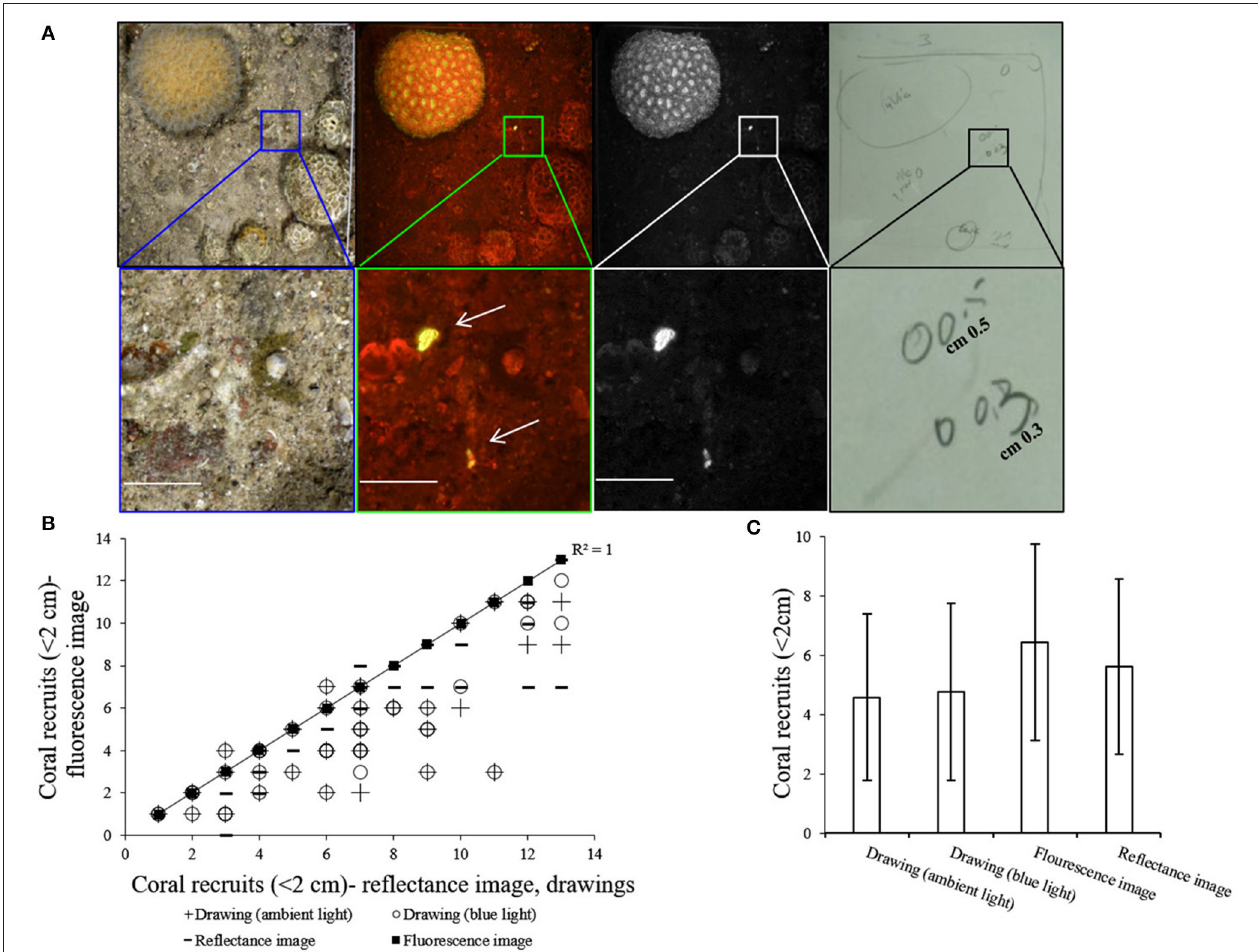
FIGURE 4 | (A) Top row (left to right)–reflectance image, fluorescence image, green channel of fluorescence image, and drawing of the same quadrat. Bottom row- magnification of the inset at the top row shows two coral recruits that were identified and drawn by the diver and are clearly seen in the fluorescence image compared to the reflectance image in which it is difficult to locate them (all scale bars are 1 cm). (B) Correlation between number of coral recruits counted in each of the fluorescence images to the number of coral recruits counted with the other methods on the same quadrat. Y axis = fluorescence image, X axis = drawing (ambient light), drawing (blue light), and reflectance image. Trendline ( R 2 = 1) represents least-squares linear regression of fluorescence imaging vs. other methods ( n = 48). (C) Mean number ( ± SD ) of coral recruits counted with each of the methods ( n =